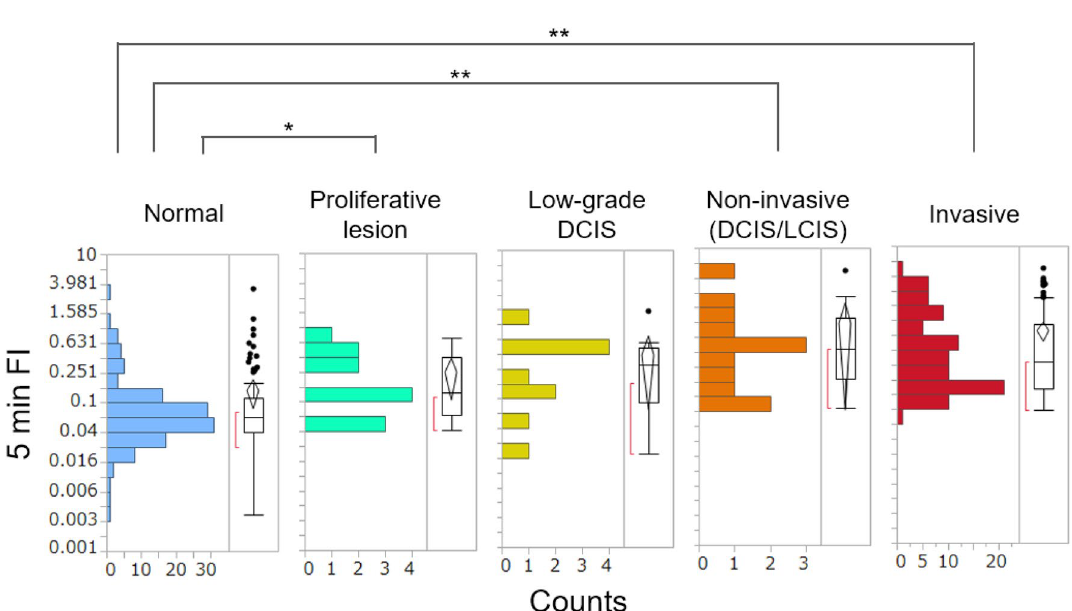
Figure 4. Differences in the 5 min FI distributions between breast cancer tissues of different lesion types . The dataset obtained in the multicenter study, including 251 sample measurements, was analyzed. * p < 0.05; ** p <